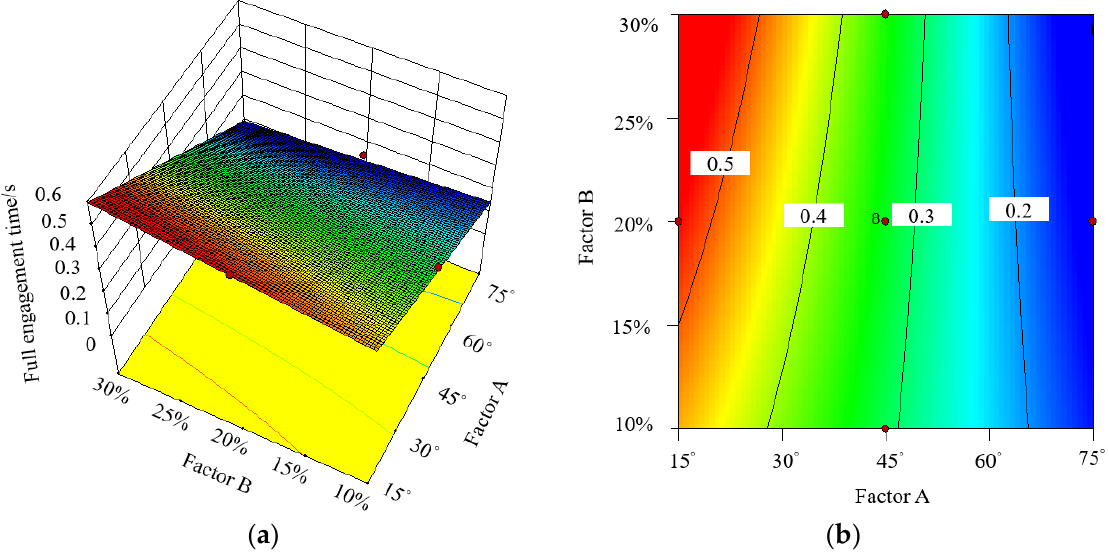
Figure 12. Response surface diagram and contour map of factor A and B on interaction of full engagement time. ( a ) Response surface diagram; ( b ) contour map. The four contour lines mapped on the bottom of Figure 12a correspond to the four types of full engagement time in Figure 12b.